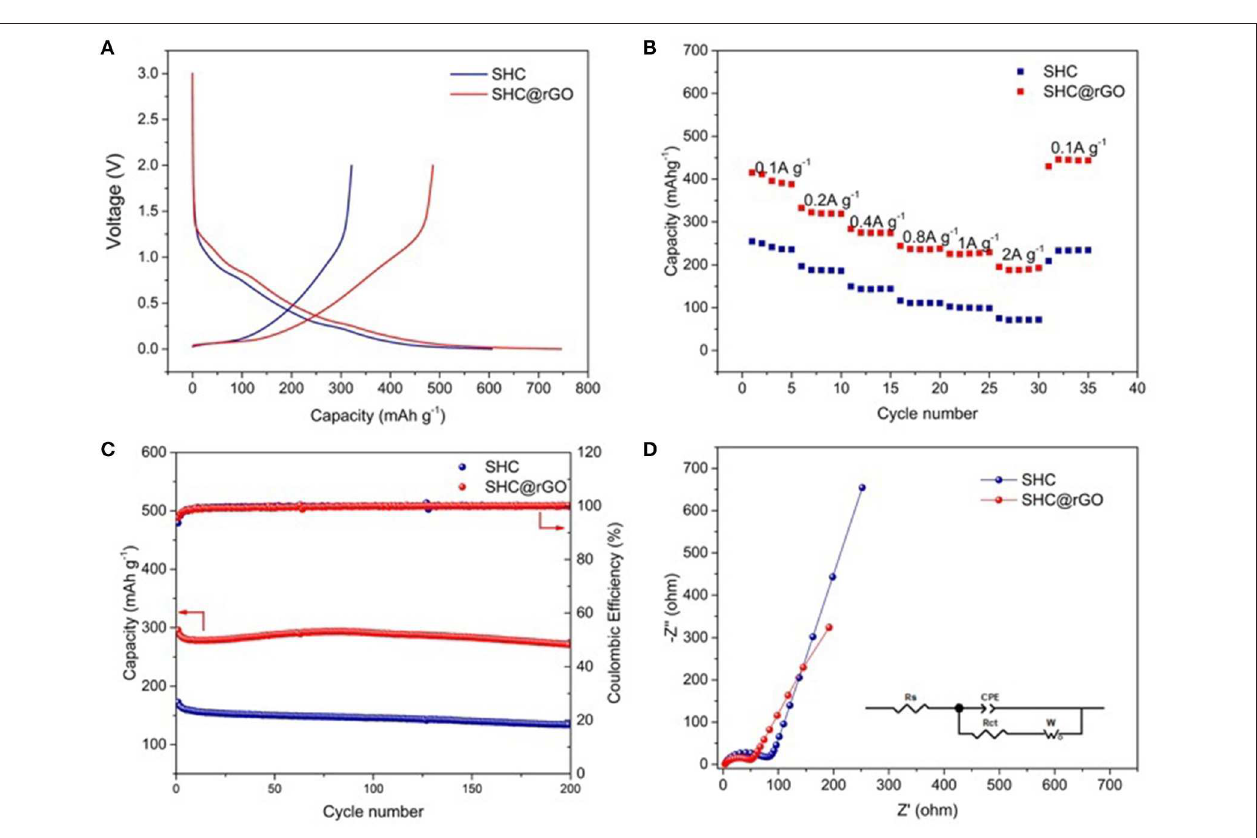
FIGURE 7 | (A) Charge and discharge curves of SHC and SHC@rGO at a current density of 50mA g − 1 between 0 and 3V, (B) ratio performance patterns of SHC and SHC@rGO with the charge/discharge current densities in the 100–2000mA g − 1 range, (C) cycle stability curves of SHC and SHC@rGO at 400mA g − 1 , and (D) Nyquist plots of SHC and SHC@rGO at the potential of 0.1V vs. Li/Li + over the frequency range from 100kHz to